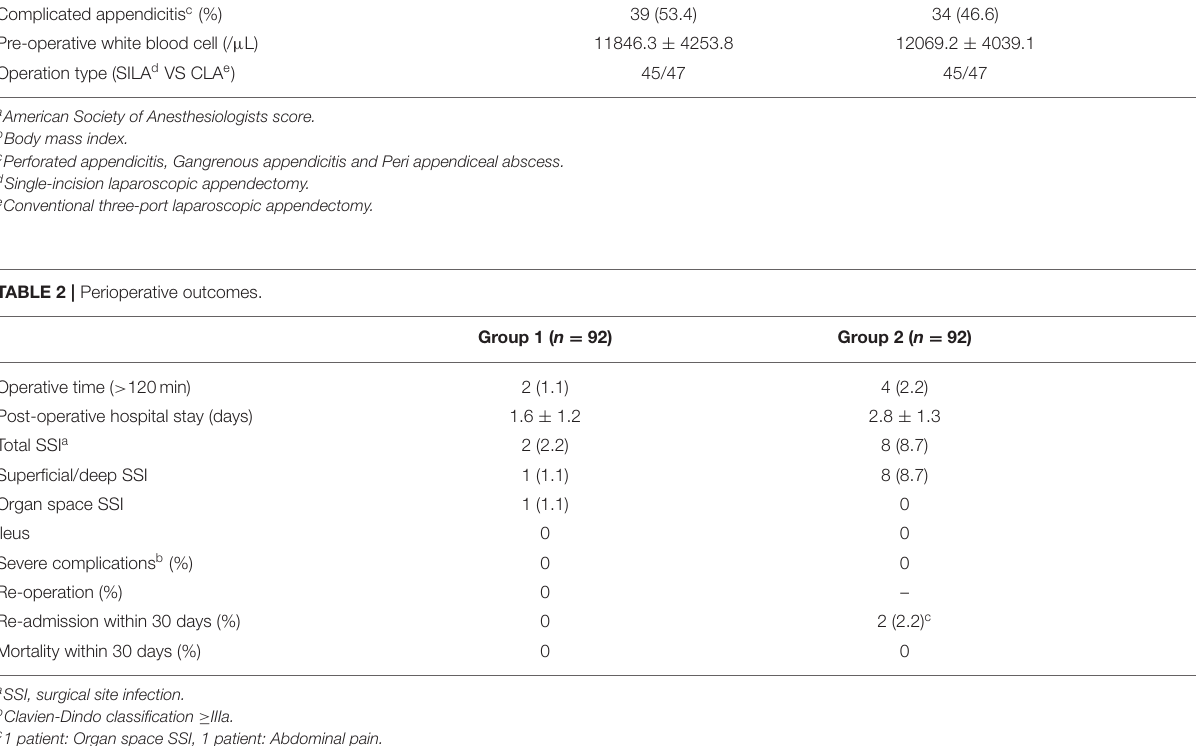
c 1 patient: Organ space SSI, 1 patient: Abdominal pain.